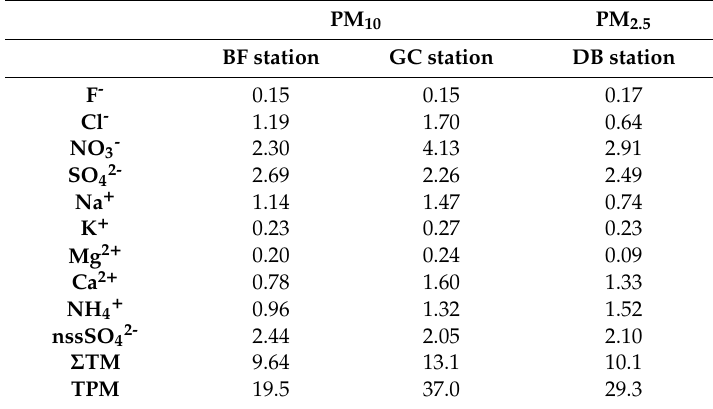
Table 3. Soluble ion concentrations. Data expressed in µ g / m 3 . nss, non-sea salt; TPM, total particulate matter ( µ g / m 3 ).